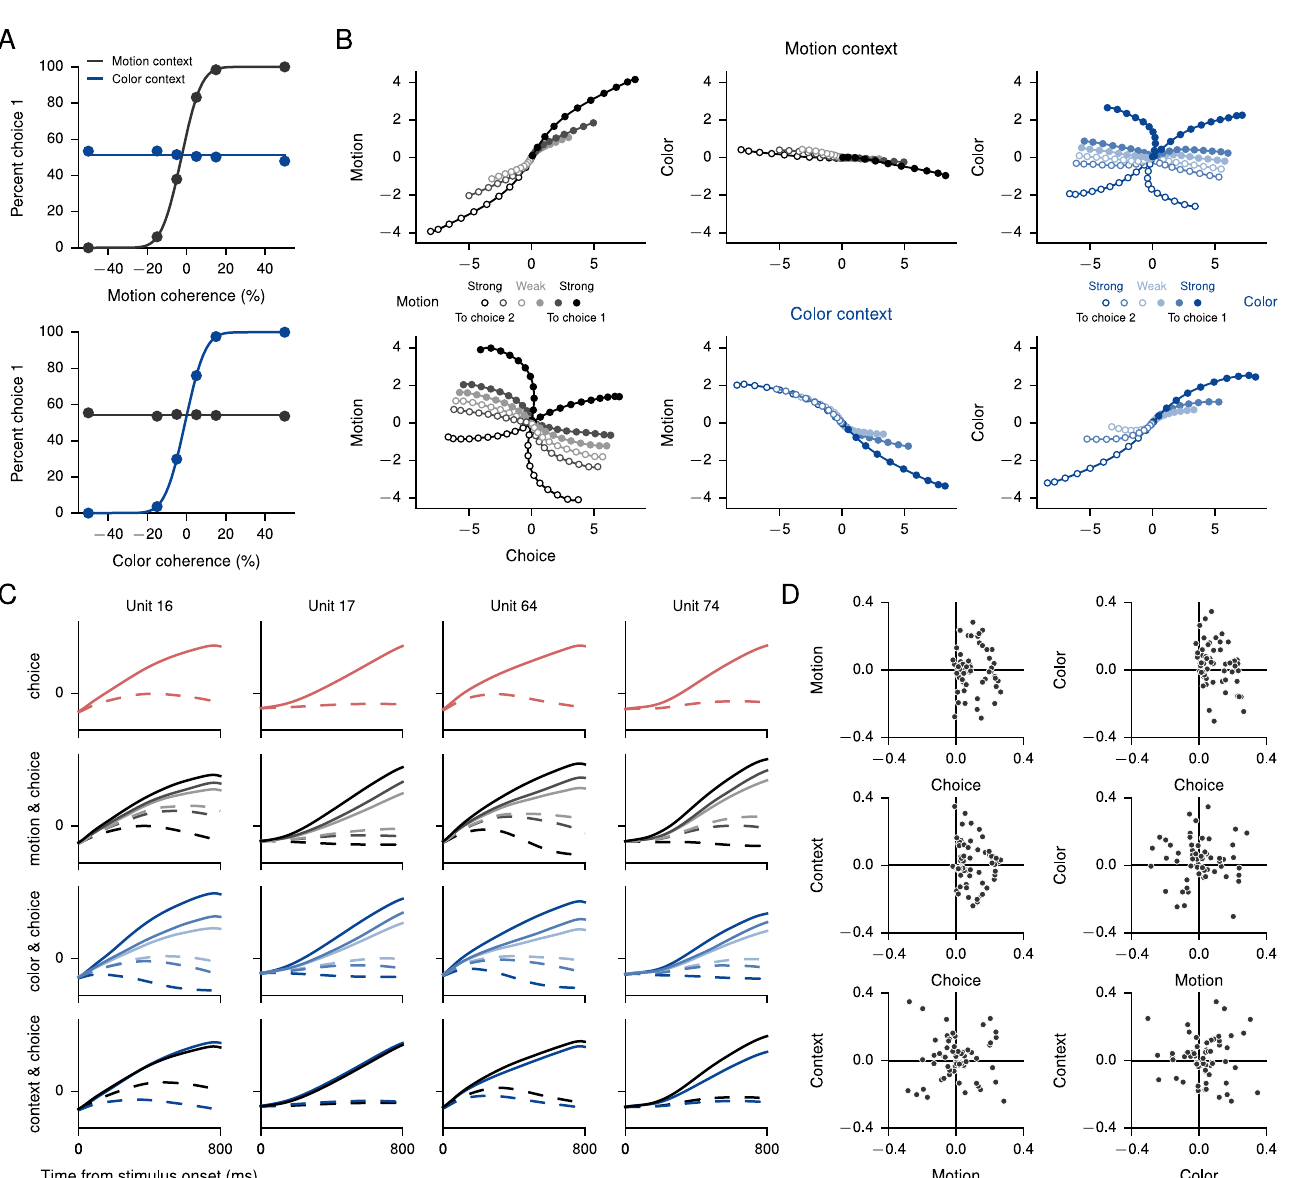
Fig 4. Context-dependent integration task. (A) Psychometric function, showing the percentage of trials on which the network chose choice 1 as a function of the signed motion (upper) and signed color (lower) coherence in motion-context (black) and color-context (blue) trials. (B) Average population responses in state space during the stimulus period, projected to the 3-dimensional subspace capturing variance due to choice, motion, and color as in [5]. Only correct trials were included. The task-related axes were obtained through a linear regression analysis. Note that “ choice ” here has a unit-specific meaning that depends on the preferred choice of the unit as determined by the selectivity index (Eq 30). For both motion (black) and color (blue), coherences increase from light to dark. Upper plots show trials during the motion context, and lower plots show trials during the color context. (C) Normalized responses of four recurrent units during the stimulus period show mixed representation of task variables. Solid lines indicate the preferred choice and dashed lines the nonpreferred choice of each unit. (D) Denoised regression coefficients from the linear regression analysis. By definition, the coefficients for choice are almost exclusively